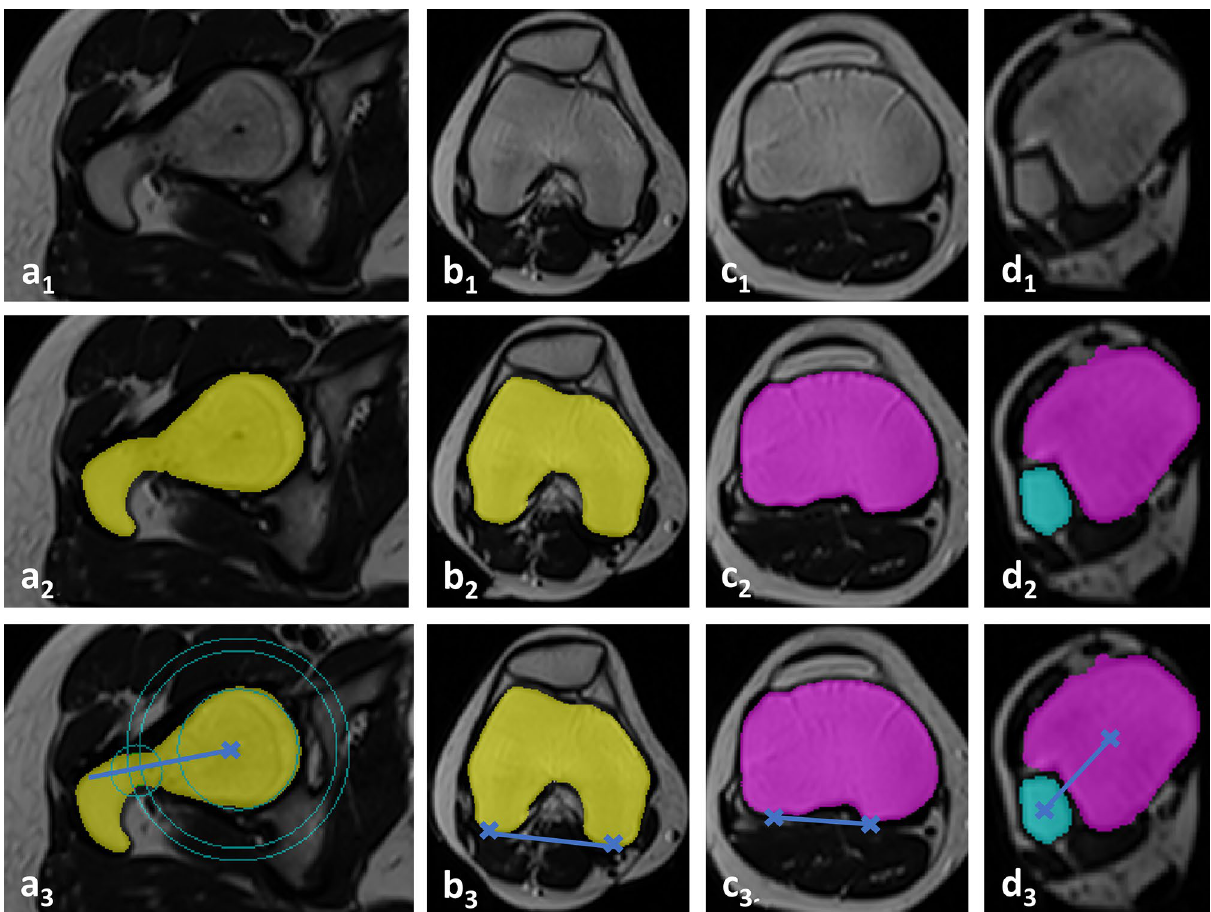
Figure 5. Visualization of the algorithm-based identification of the reference lines. Indicated are the original MR images (a 1 -d 1 ), their segmentation outlines on selected axial images (a 2 -d 2 ), and the corresponding reference lines (a 3 -d 3 ) as determined by the algorithm. Proximal femur ( a ), distal femur ( b ), proximal tibia ( c ), and distal tibia ( d ). Reference lines and points are blue. For algorithmic details please refer to Fig. 4. Femur (yellow), tibia (purple), and fibula (light blue). 19-year-old